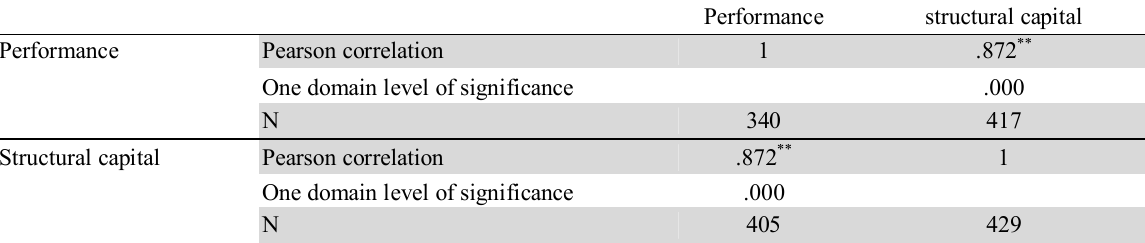
The summary of testing the second sub-hypothesis Performance structural capital Performance Pearson correlation 1 .872 ** One domain level of significance .000 N 340 417 Structural capital Pearson correlation .872 ** 1 One domain level of significance .000 N 405